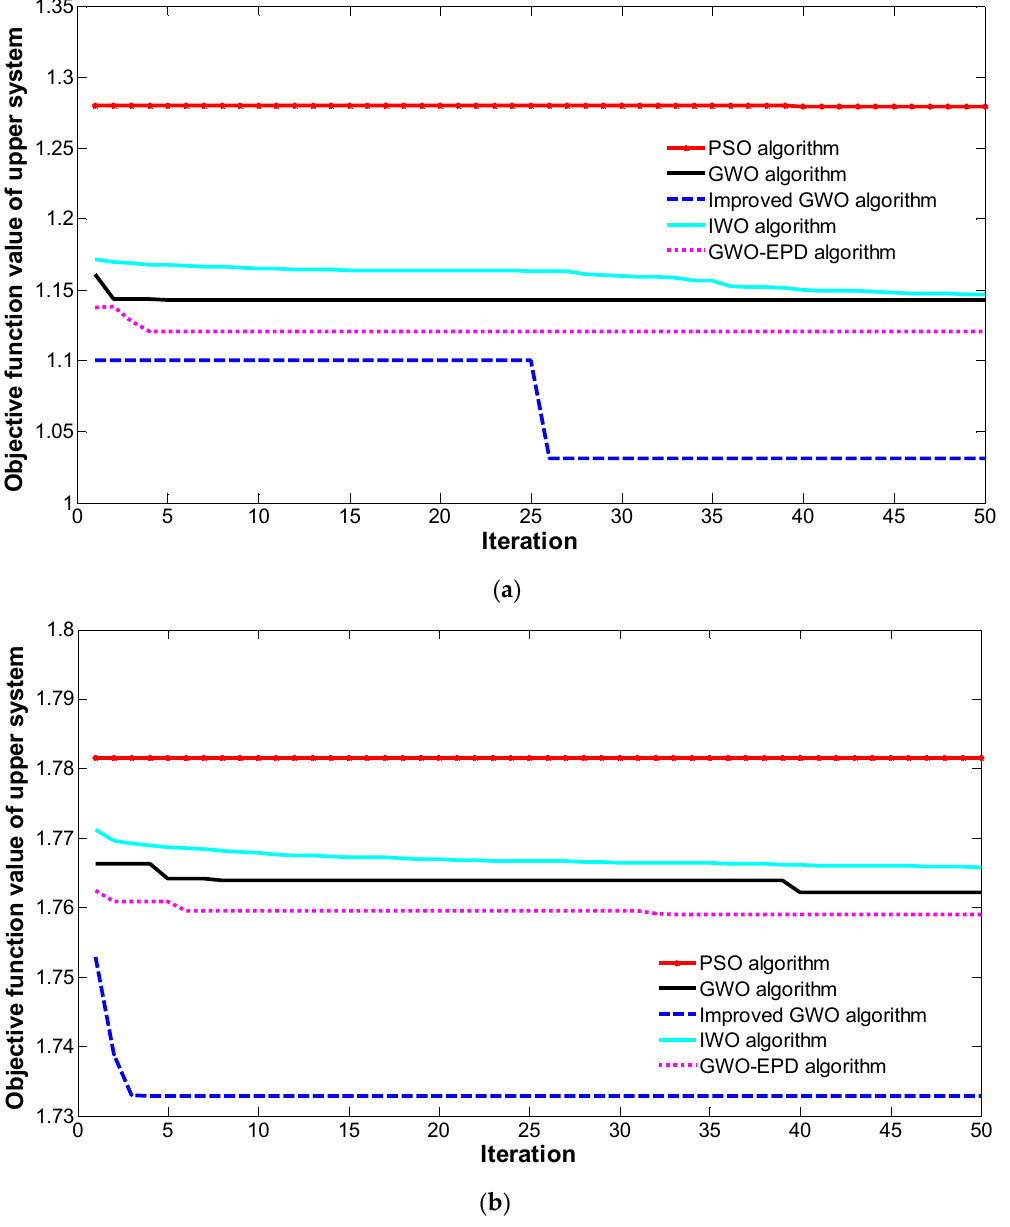
Figure 14. Comparison of the optimal dispatching schemes of the distribution network comprising the micro energy grid on a typical day in the winter ( a ), and in the summer ( b ).